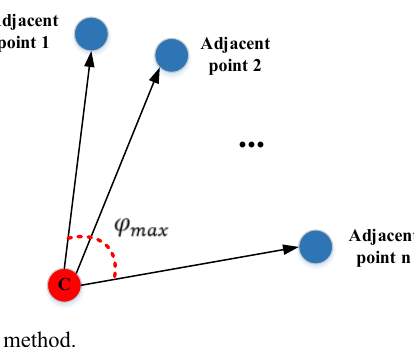
Fig. 5. The improved search